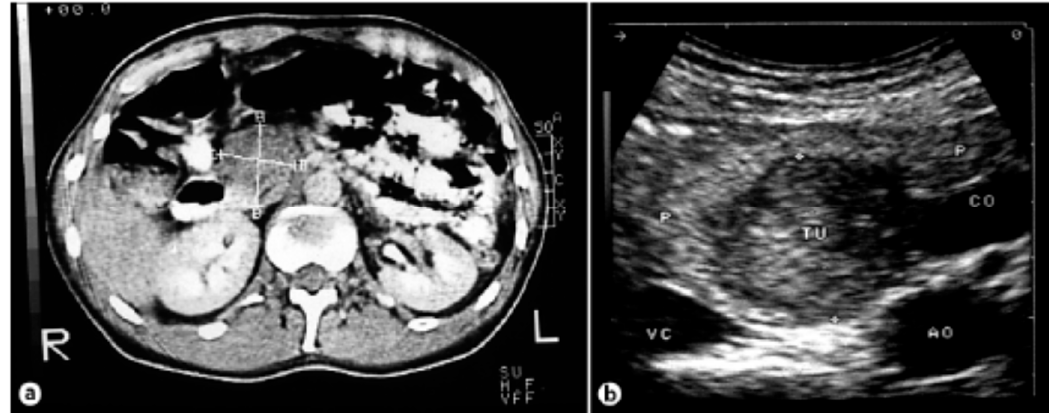
Figure 8. ( a ) Computed tomography of the abdomen showing a tumor of the pancreas 4.2 × 3.3 cm in size. ( b ) Intraoperative ultrasound showing a hypoechogenic tumor [26].